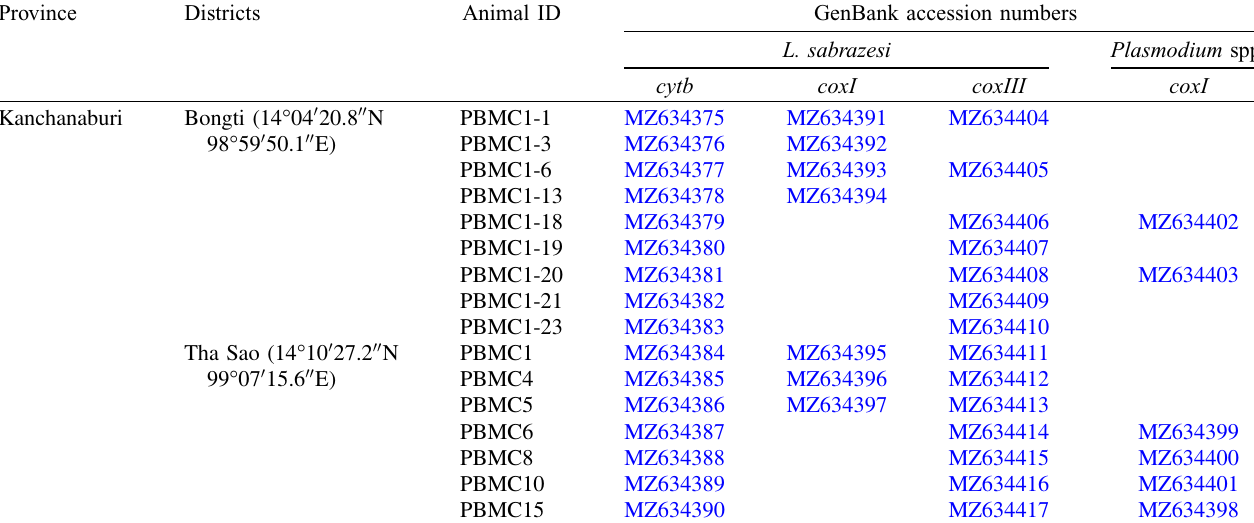
Table 1. The L. sabrazesi and Plasmodium spp. mitochondrial nucleotide sequences ampli fi ed in Thailand deposited in GenBank.